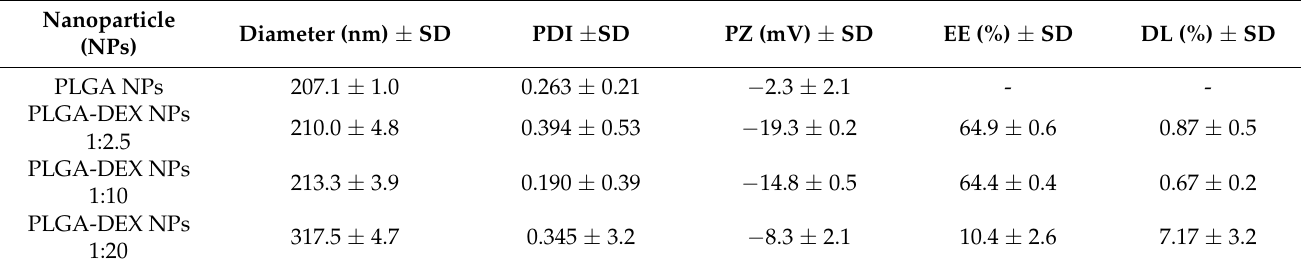
Table 2. Diameter, polydispersity index (PDI), zeta potential (PZ), encapsulation efficiency (EE), and drug-loading (DL) in the analysis of PLGA and PLGA-DEX